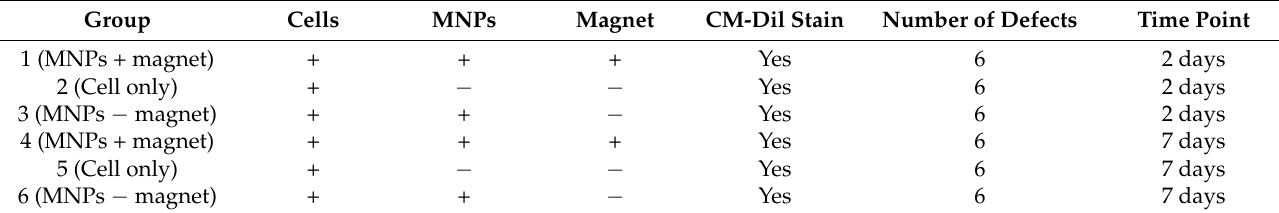
Table 1. Details of the exerimental